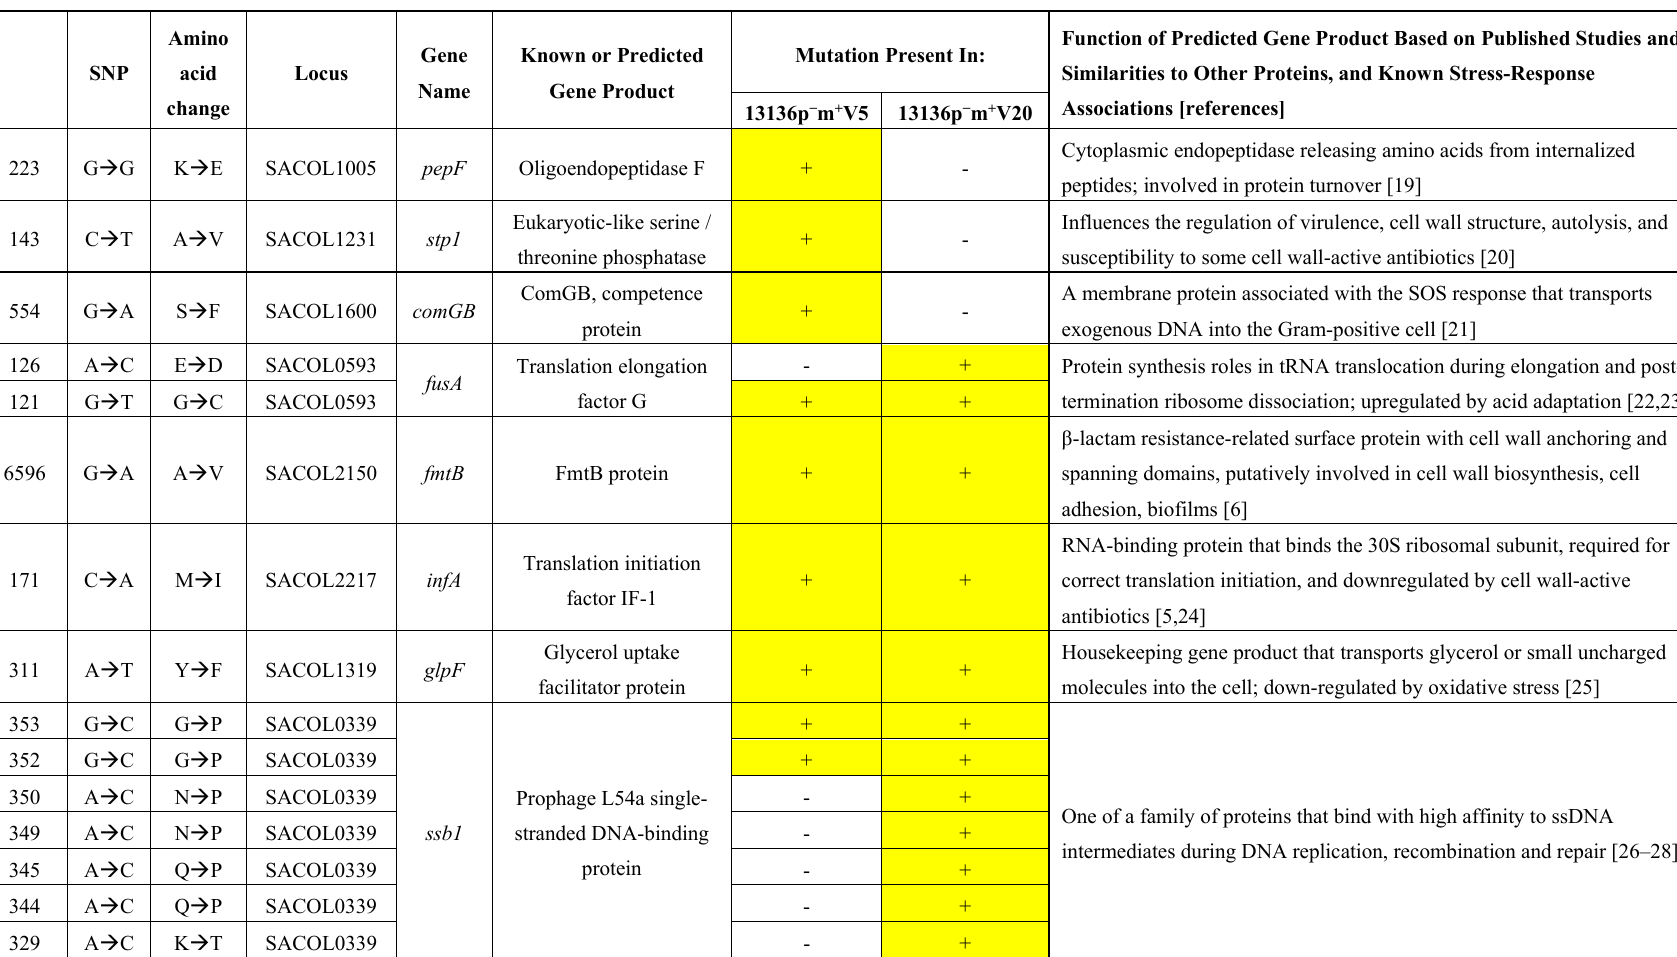
Table 1. Mutations resulting in protein amino acid changes present in VISA strains 13136p − m + V5 and 13136p − m + V20 (yellow cells) following in-vitro passage-selection from VSSA parent 13136p − m +